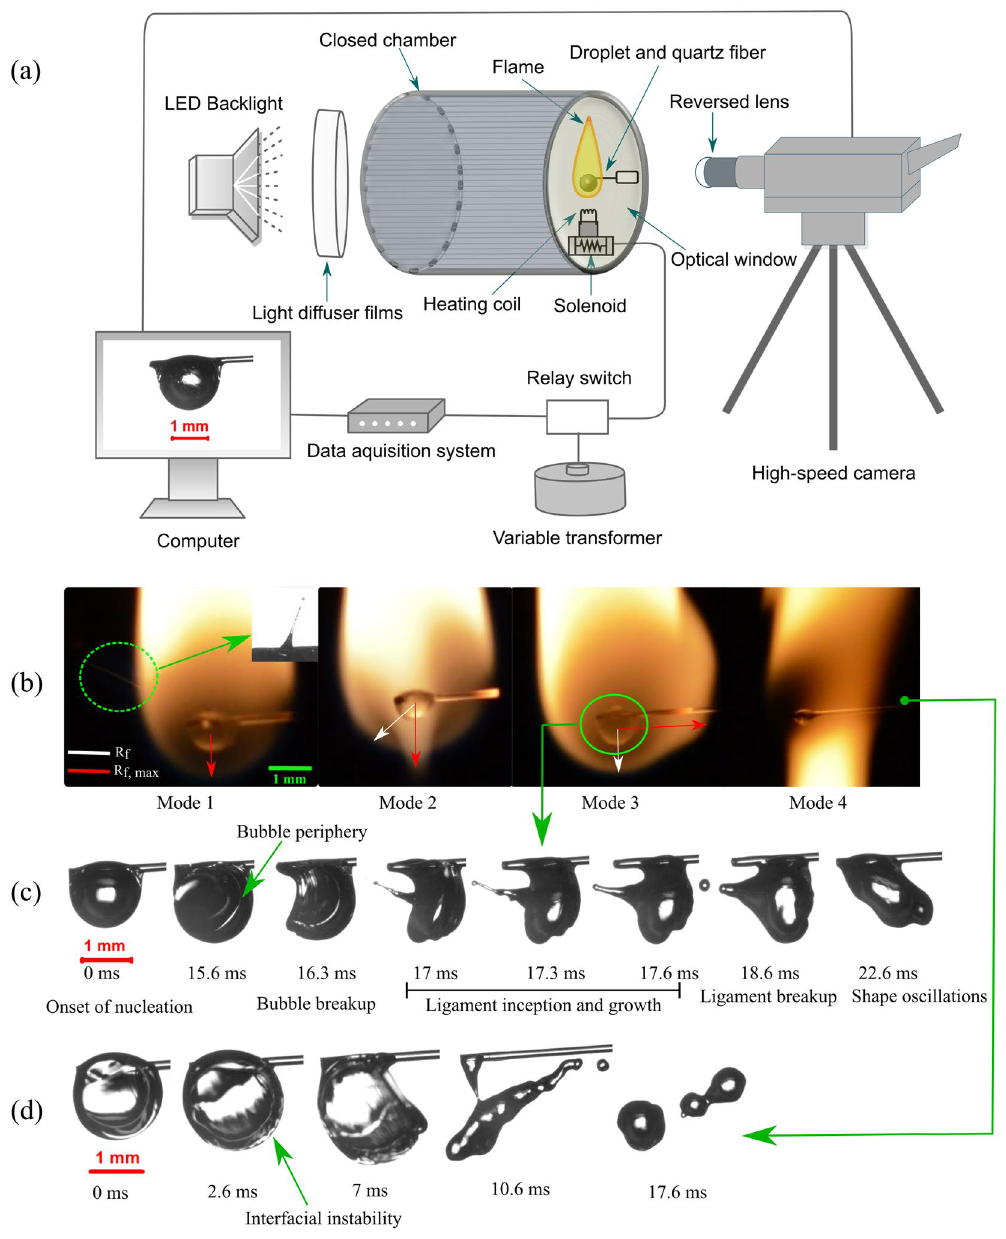
Figure 1. ( a ) Schematic of the experimental apparatus. Schematic of various types of droplet breakup. ( b ) Modes of ligament breakup; ( c ) A typical temporal sequence of Mode 3 type bubble breakup, ligament growth, ligament breakup and subsequent shape oscillations; ( d ) Micro-explosion due to both internal expansion and interfacial